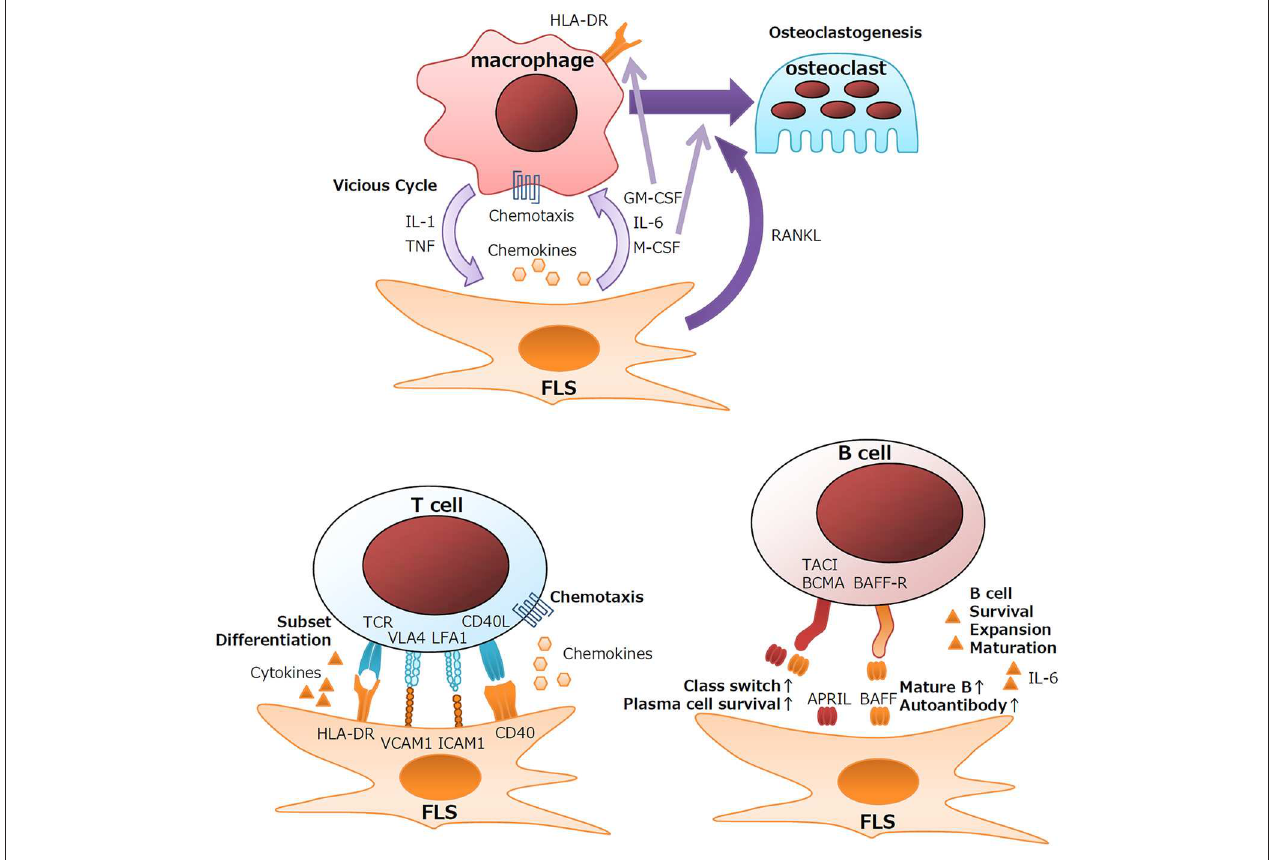
FIGURE 1 | Schematic outline of interactions between FLS and immune